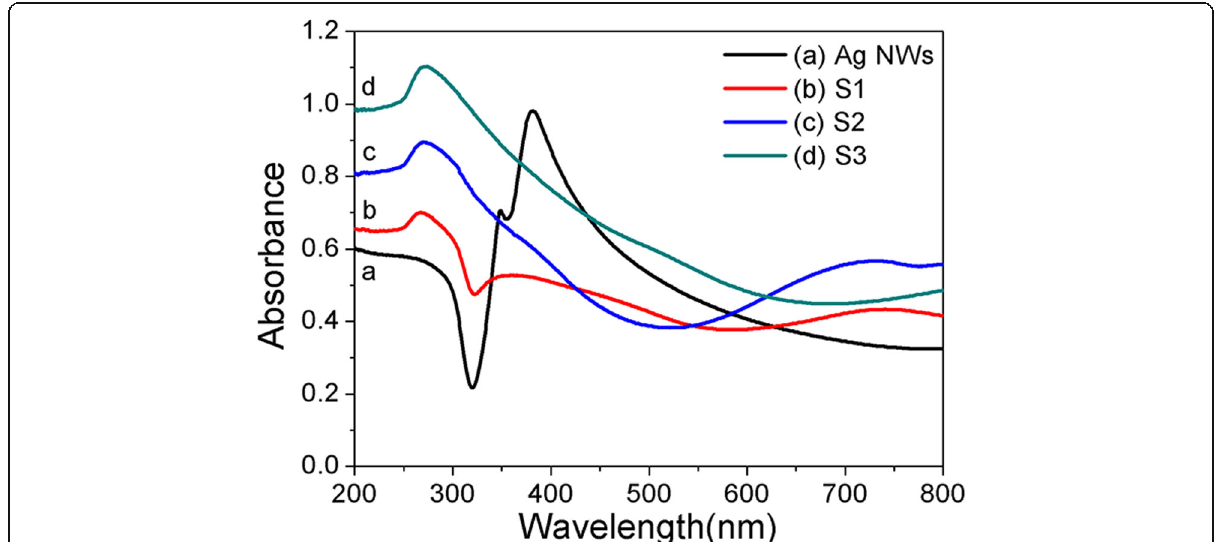
Fig. 5 The UV-vis absorption spectra of Ag NWs and Ag/Au/AgCl sample S1 – S3